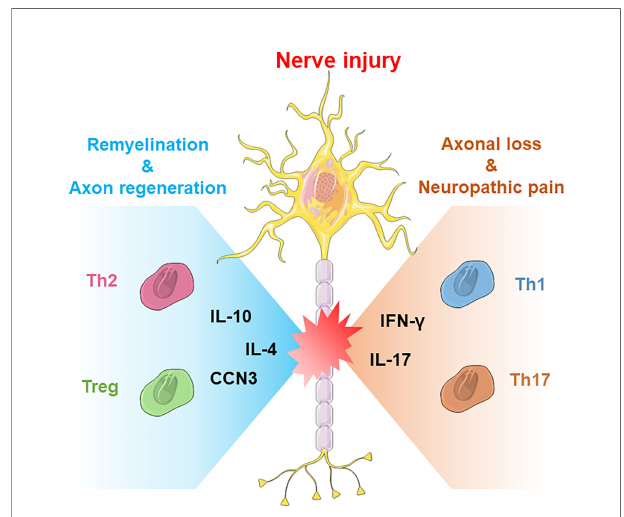
FIGURE 1 | The neuroprotective and neurodestructive impacts of T-cell subsets in CNS/PNS nerve injury. Generally, Th2 cells and Treg cells produce anti-in fl ammatory cytokines such as IL-4 or IL-10 to promote nerve repair, whereas Th1 and Th17 cells produce IFN- g or IL-17 to boost acute in fl ammatory responses.